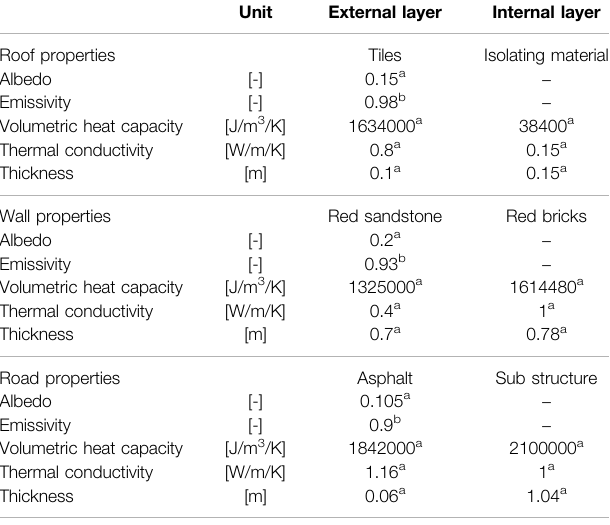
TABLE 2 | TEB-Surfatm input parameters for impervious